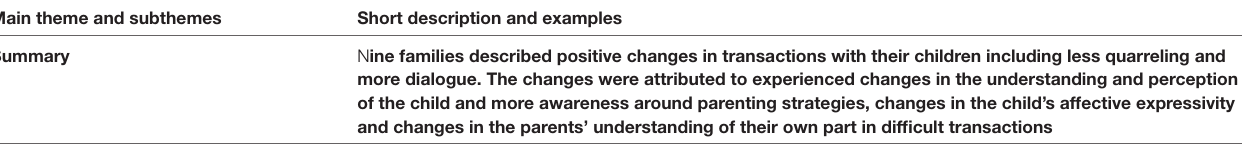
TABLE 5 | Described changes in